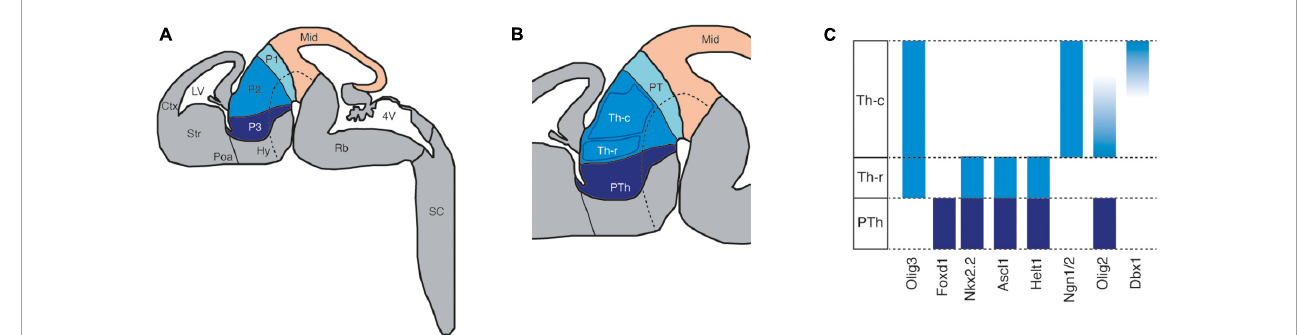
FIGURE2 The patterning of the developing diencephalon. (A) The schema represents a sagittal view of the developing mouse brain highlighting the midbrain (Mid) and the subdivisions, known as prosomeres (P1, P2, and P3), of the diencephalon according to the prosomeric model. Ctx: cortex; Hy: hypothalamus; LV: lateral ventriculus; Poa: preoptic area; Rb: rhombencephalon; SC: spinal cord; Str: striatum; 4V: fourth ventriculus. (B) The two progenitor domains of the prosomere 2 or thalamus (Th): Th-c (caudal) and Th-r (rostral). PTh: prethalamus; PT: pretectum. (C) Representative expression patterns of transcription factors in the different the progenitor domains of prosomeres 2 and